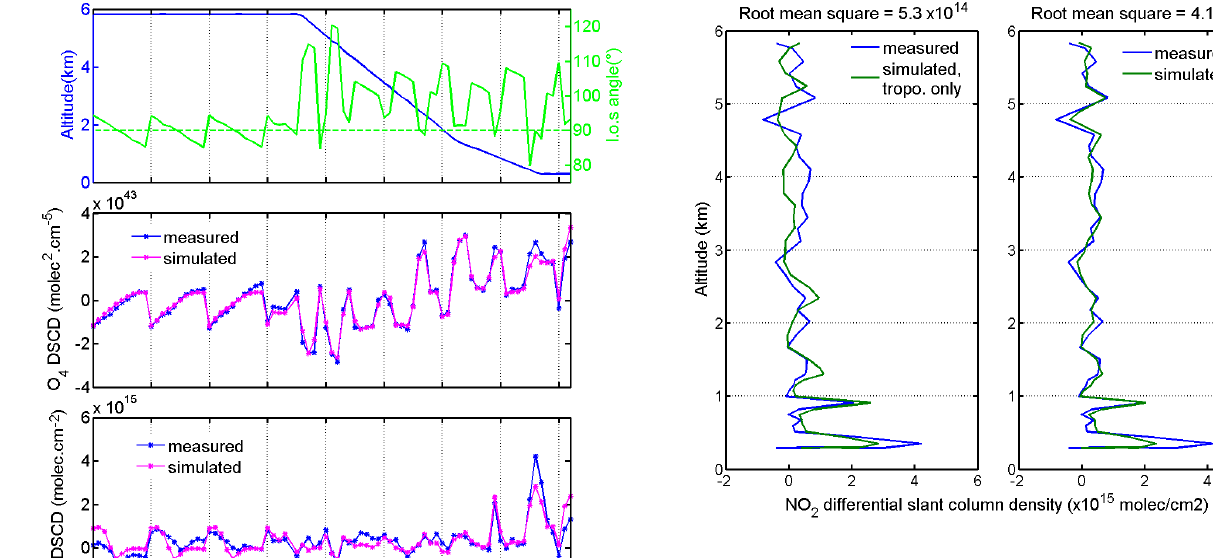
Fig.9. InfluenceofthestratosphereonNO 2 troposphericobservations. MeasuredNO 2 DSCDduringthesounding(blue)arecomparedwith simulations (green) neglecting the stratosphere (left) or not (right). The latter agrees better with the observations. Fig. 8. DSCD measurements during the as0831 flight (8 April 2008). The upper panel shows the plane altitude (blue) and the telescope line-of-sight angle (green, 0 ◦ is nadir, 90 ◦ horizontal). On the middle and bottom panels, measured DSCD, respectively of O 4 and NO 2 , are compared with simulations. Oscillations on the DSCD series are caused by the telescope scanning. Discrepancies between measured and simulated DSCD are larger in the boundary layer, where true aerosol extinction and NO 2 concentration are different from the model.